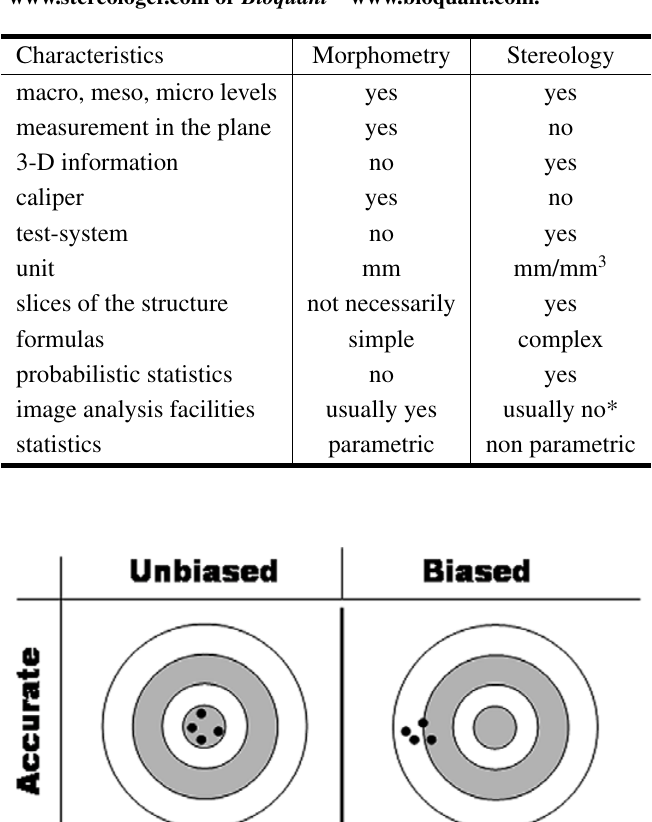
Morphometry vs. Stereology (*some systems have been announced to